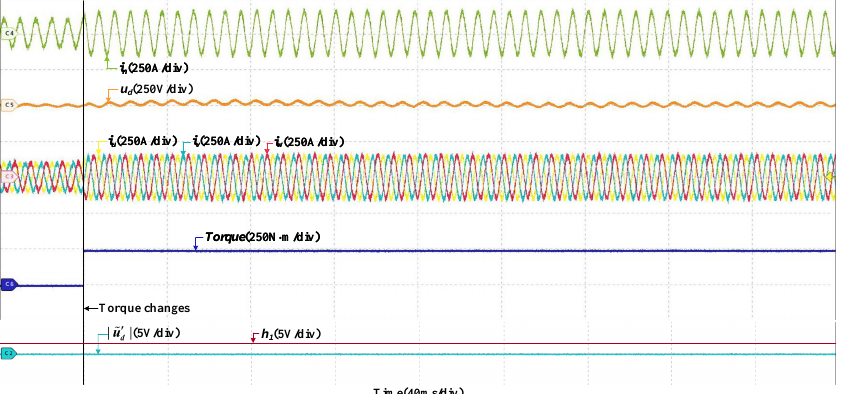
Figure 7. HIL results when the load torque changes.